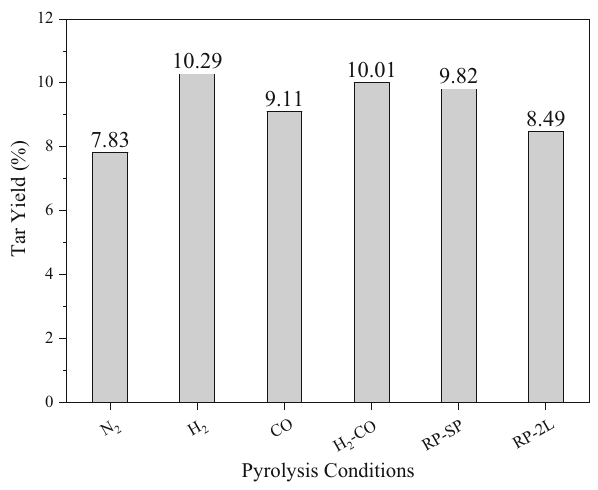
Fig. 7 Tar yield under different coal pyrolysis conditions